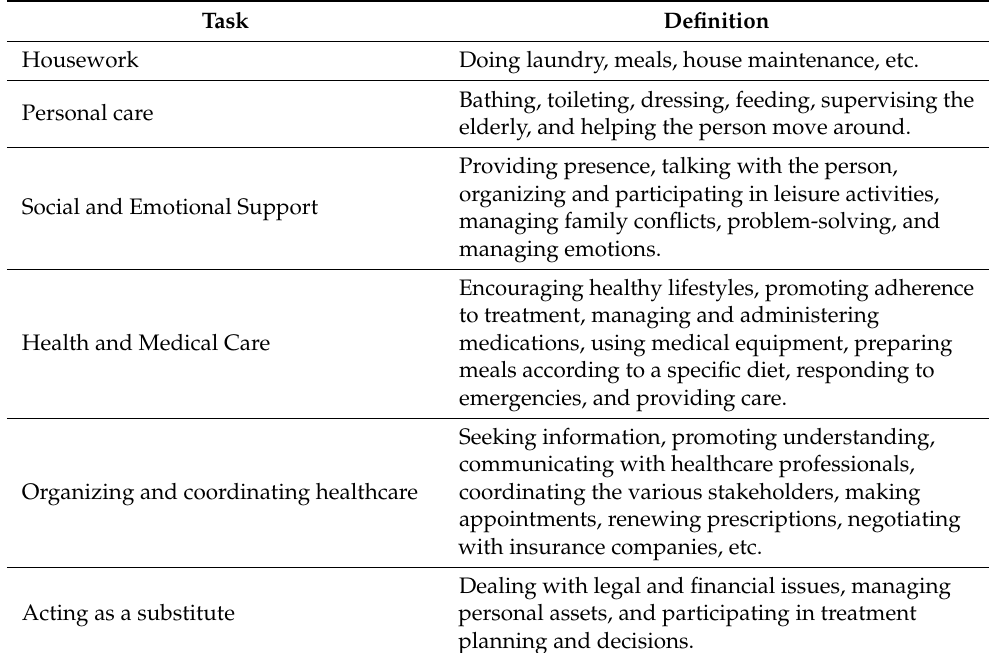
Table 1. The different tasks that informal caregivers of seniors can do and their definitions.